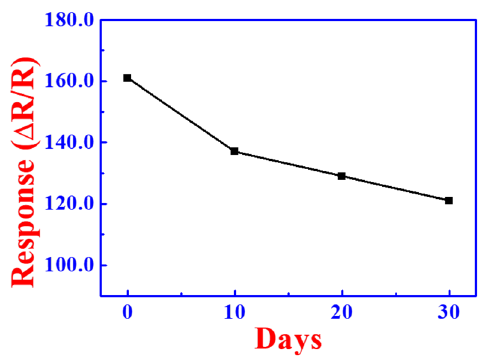
Figure 9. The APN device durability of 0, 10, 20, and 30 days.